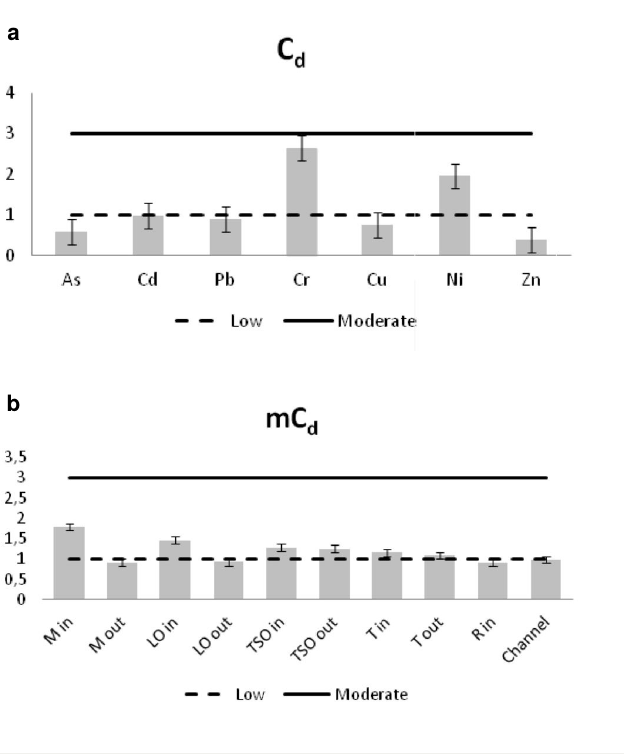
The dashed and continuous lines represent the thresholds for low and moderate contamination of the sediment,